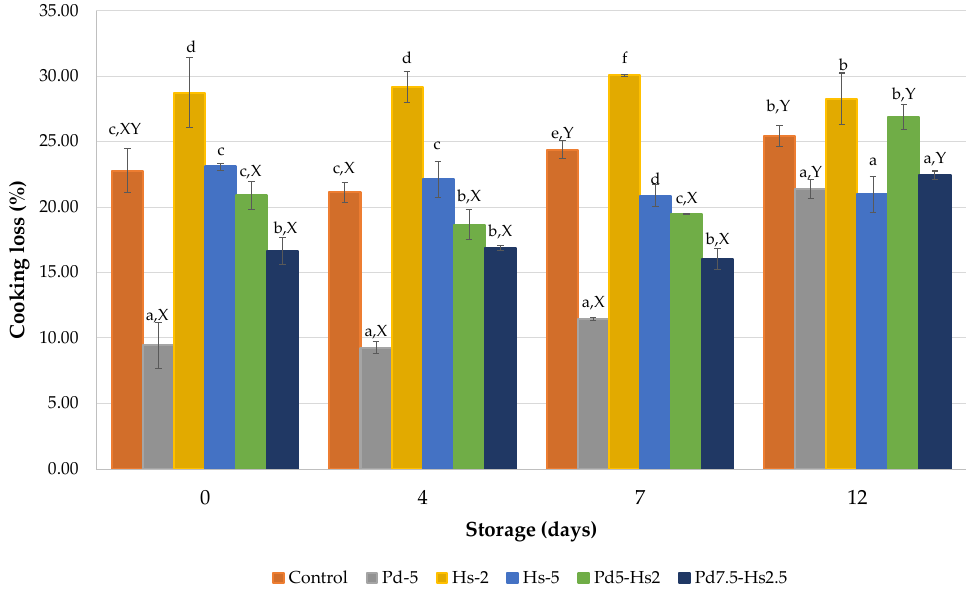
Figure 3. Cooking losses (%) of formulations with Pd and Hs powders. a–f Mean values for each day with different letters differ significantly ( p < 0.05). X,Y Mean values for each formulation with different letters differ significantly ( p < 0.05).